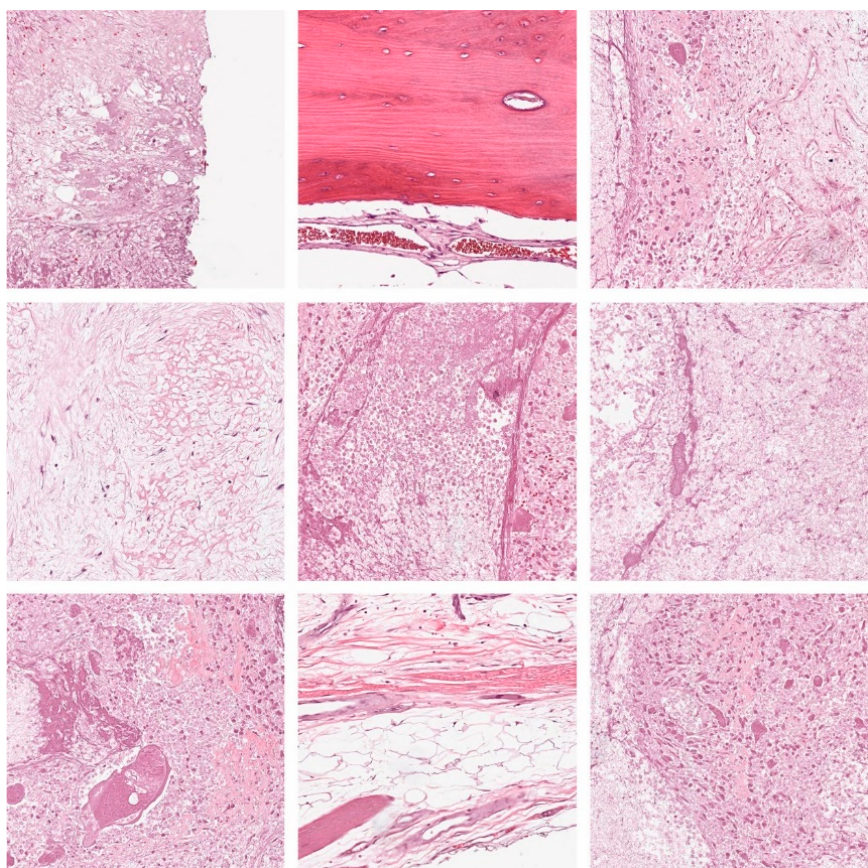
Figure 5. Sample images of osteosarcoma.